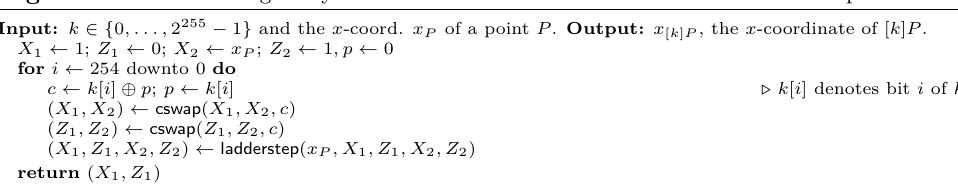
Algorithm 1 The Montgomery ladder for x -coordinate-based X25519 scalar